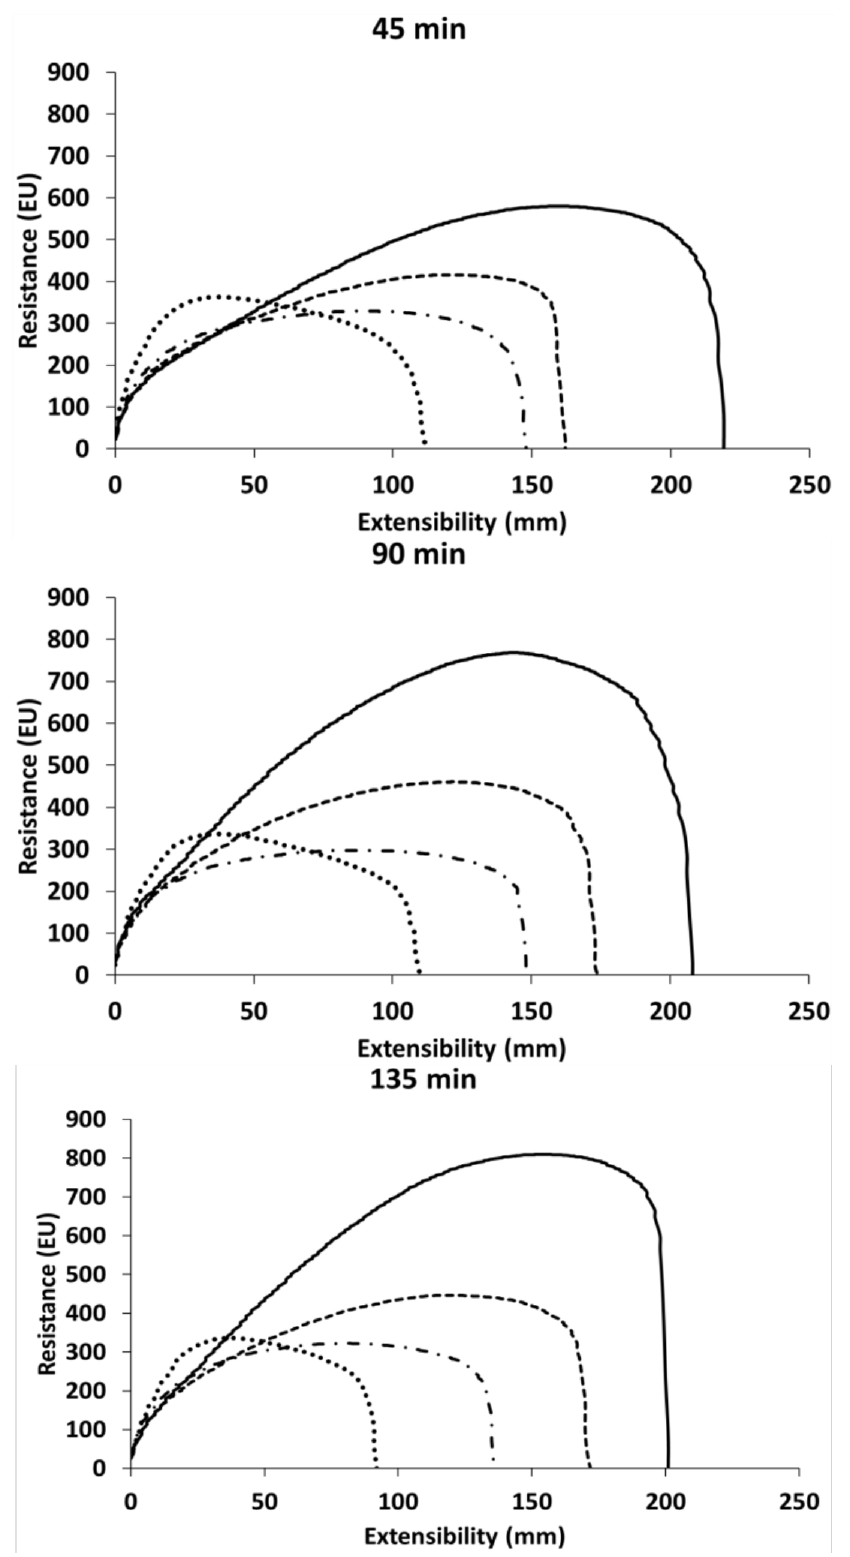
Figure 3. Extensional properties of wheat (solid line), and with increasing replacement level of cricket powder (5%: dash line; 10%: dash–dotted line; 20%: dotted line), after 45 min, 90 min, and 135 min of resting time. EU—Extensograph